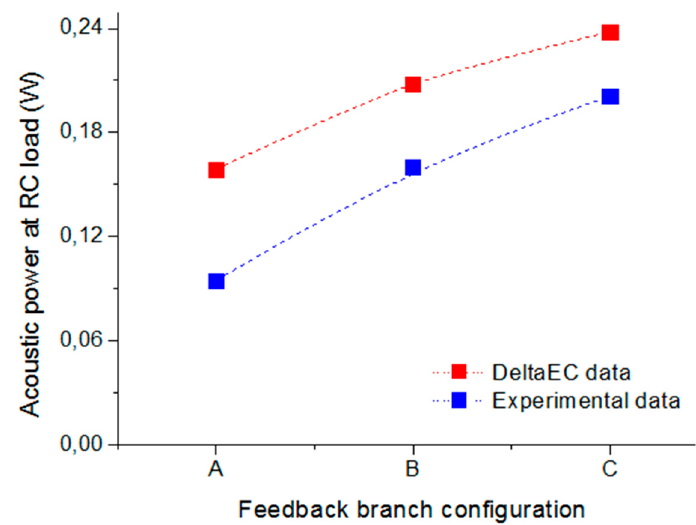
Figure 4. Comparison of the thermoacoustic performance by DeltaEC and experimental data. Feedback branch compliance increases between case A and C, while the length is reduced. C is defined in Table 1 ( D C = 0.435 m, L C = 0.187 m, D L = 0.016, and L L = 0.187). Case A corresponds to ( D C = 0.02 m, L C = 0.41 m, D L = 0.015, and L L = 0.185). Case B corresponds to ( D C = 0.025 m, L C = 0.25 m, D L = 0.015, and L L = 0.24).